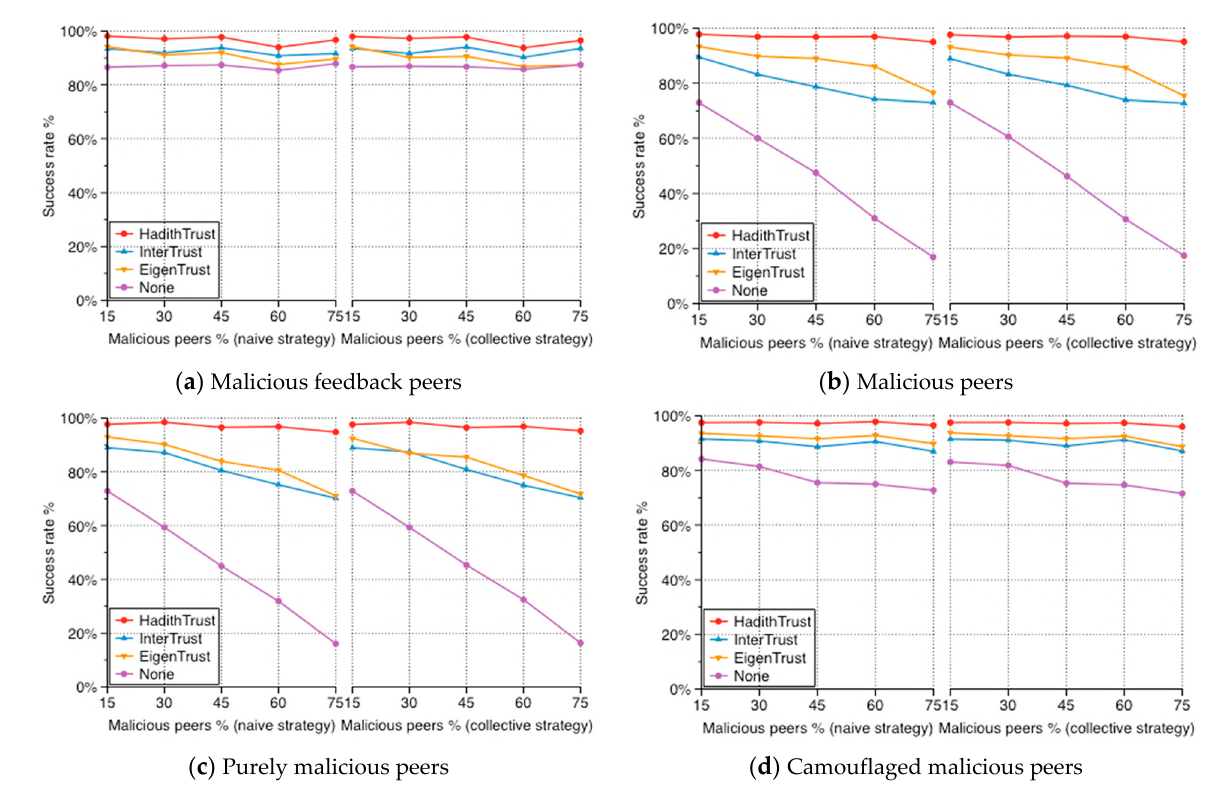
Figure 12. Success rate.